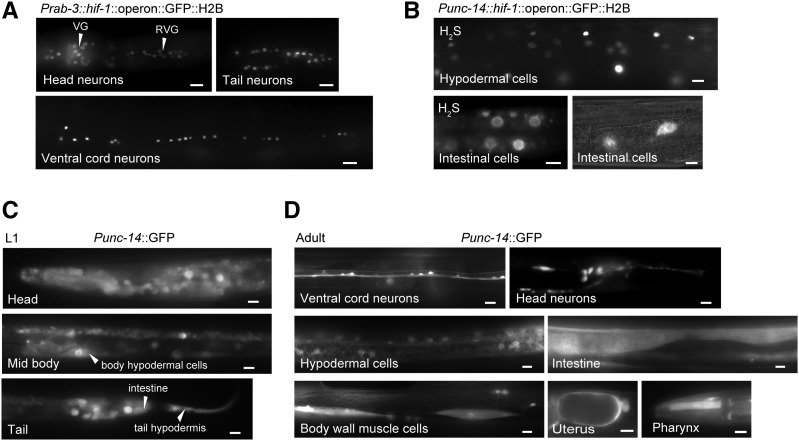
The unc-14 promoter is active in many nonneuronal cells. (A) Visualization of GFP expressed from Prab-3::hif-1::operon::GFP::H2B (transgene yakEx125). Tail, head, and ventral cord neurons are shown from the ventral aspect of the same animal. VG, ventral ganglia; RVG, retrovesicular ganglia. In all images: bar, 10 μm. (B) Representative images of adult hif-1(ia4); Punc-14::hif-1::operon::GFP::H2B (transgene yakEx144) animals. GFP expression in hypodermal and intestinal cells is shown. Bar, 10 μm. (C and D) Representative images of (C) L1 and (D) adult transgenic animals expressing Punc-14::GFP (transgene yakEx142). Representative animals are shown with GFP expression in hypodermis, intestine, muscle, uterus, pharynx, and neurons. Bar, 5 μm in (C) and 10 μm in (D).